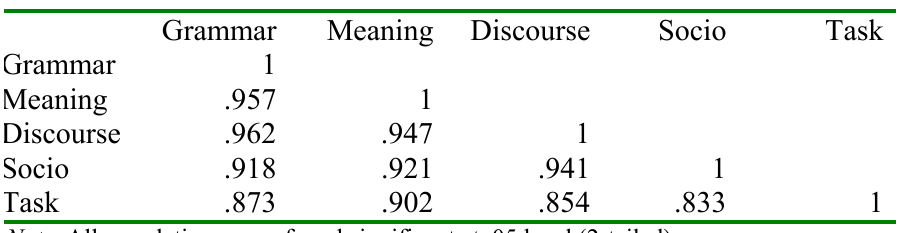
Correlation Analyses after taking out 10 Students (N=80)